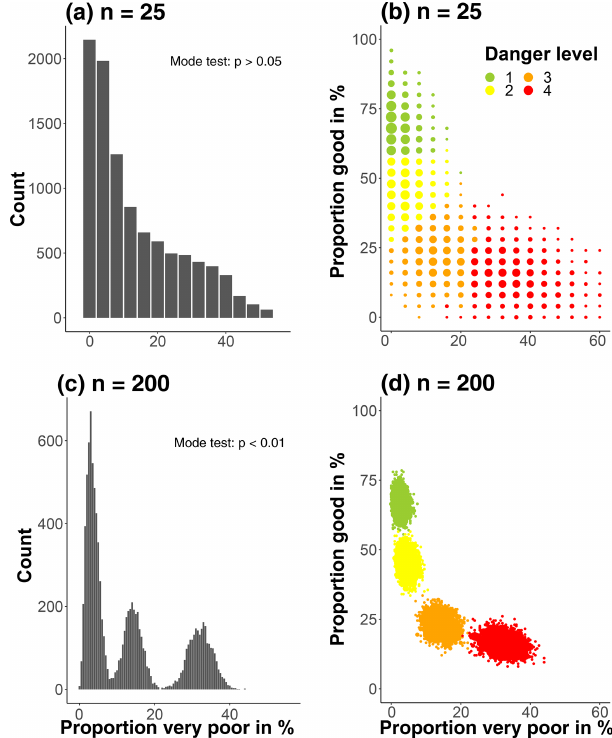
Figure 8. Simulated proportions of very poor and good snowpack stability derived from RB tests for different number of samples n drawn in each of the bootstraps ( a and b : n = 25, c and d : n = 200). In the histograms (a, c) the proportion of very poor stability is shown; in the scatterplots (b, d) the most frequent danger level for a combination of very poor and good stability is shown. Note, the histogram in (a) is identical to Fig. 2c. The larger the sample size n , the more the data became multimodal and clustered around the means of each danger level. This is indicated by the p value (mod- etest, median p value of 10 repetitions, Ameijeiras-Alonso et al., 2018) in (a) and (c)